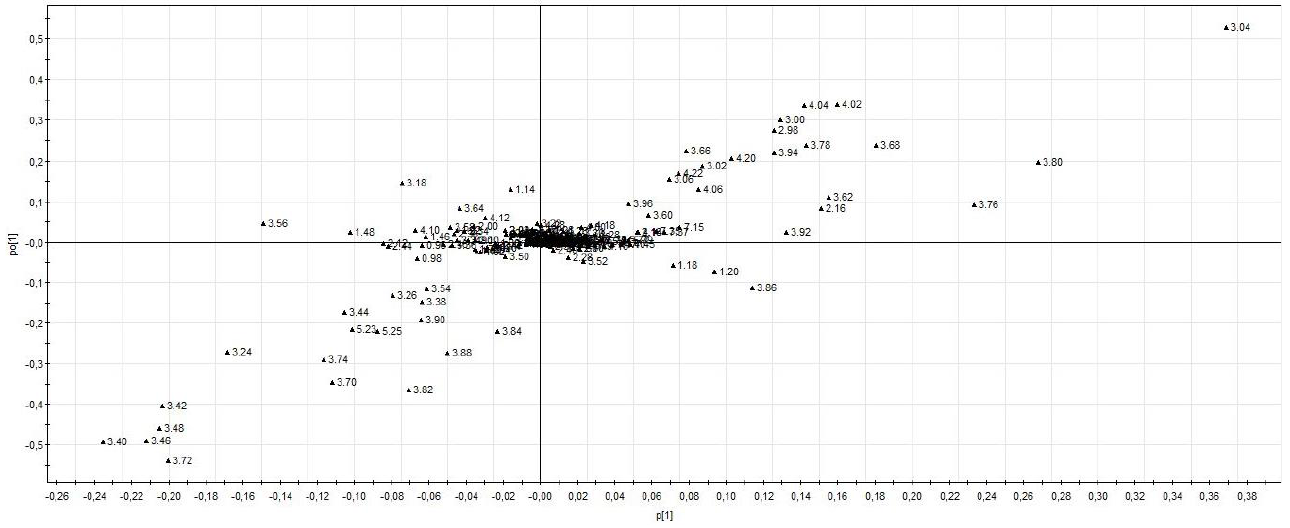
Figure 2. Scores plot (septic shock versus ICU control group). Septic shock patients (in blue) versus ICU control patients (in green). The supervised OPLS-DA method shows a significant difference between septic shock patients and ICU control patients (CV-ANOVA, p = 0.006).